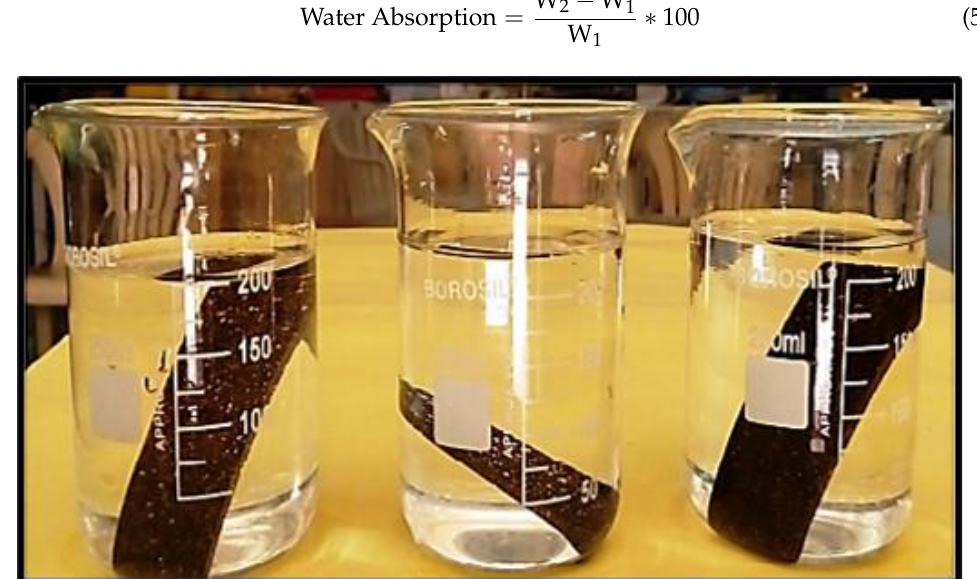
Figure 3. Photographic image of water absorption behaviour experiment.